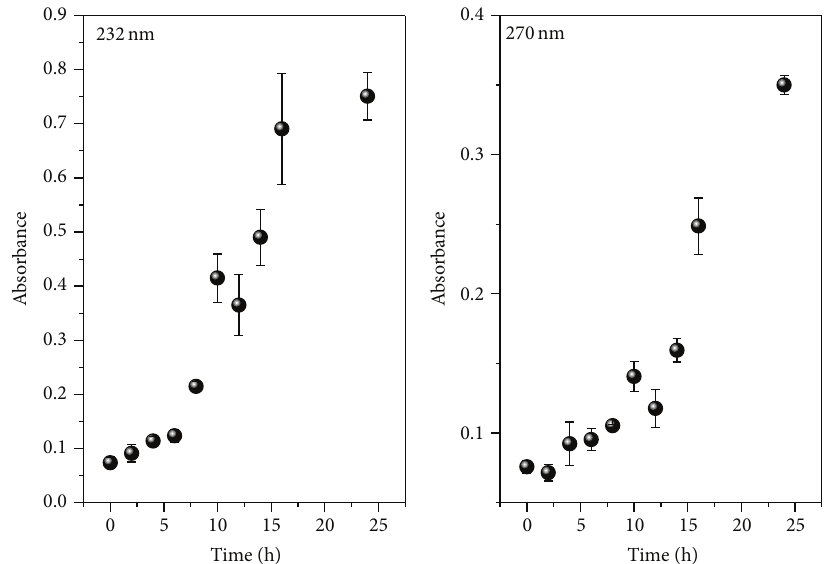
Figure 3: Baru oil absorbance at 232 and 270 nm as a function of the heating time. The oil samples were heated at 110 ∘ C.